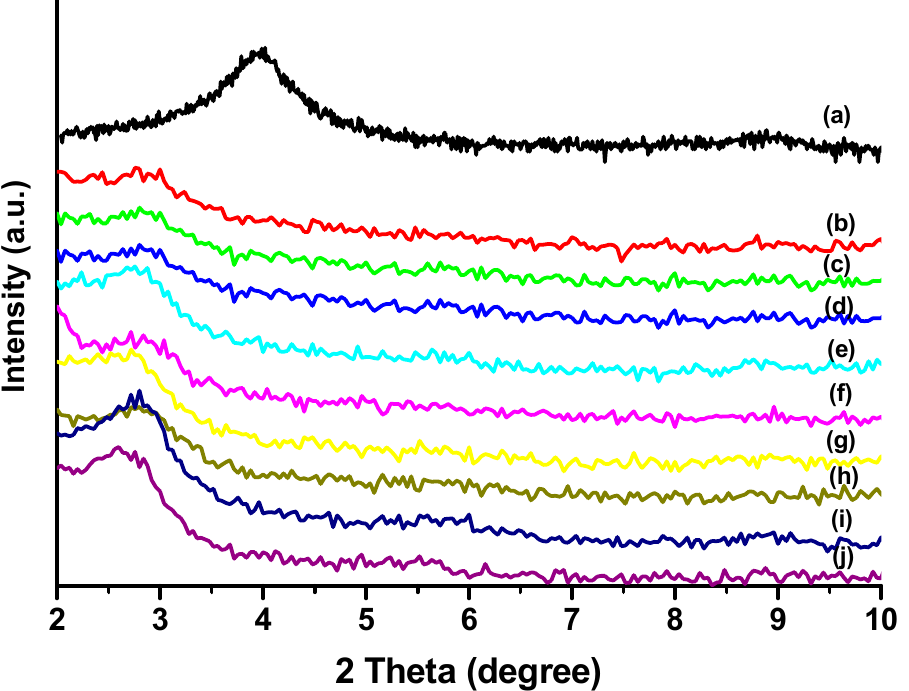
Figure 3. Curve ( a ) was the X-ray diffraction pattern of the modified o-MMT. Curves ( b – d ) were the X-ray diffraction patterns of PLLA-PEG200/o-MMT; the amount of o-MMT was 0.5 wt%, 1 wt%, and 1.5 wt%, respectively. Curves ( e – g ) were the X-ray diffraction patterns of PLLA-PEG1000/o-MMT; the amount of o-MMT was 0.5 wt%, 1 wt%, and 1.5 wt%, respectively. Curves ( h – j ) were the X-ray diffraction patterns of PLLA-PEG2000/o-MMT; the amount of o-MMT was 0.5 wt%, 1 wt%, and 1.5 wt% respectively.